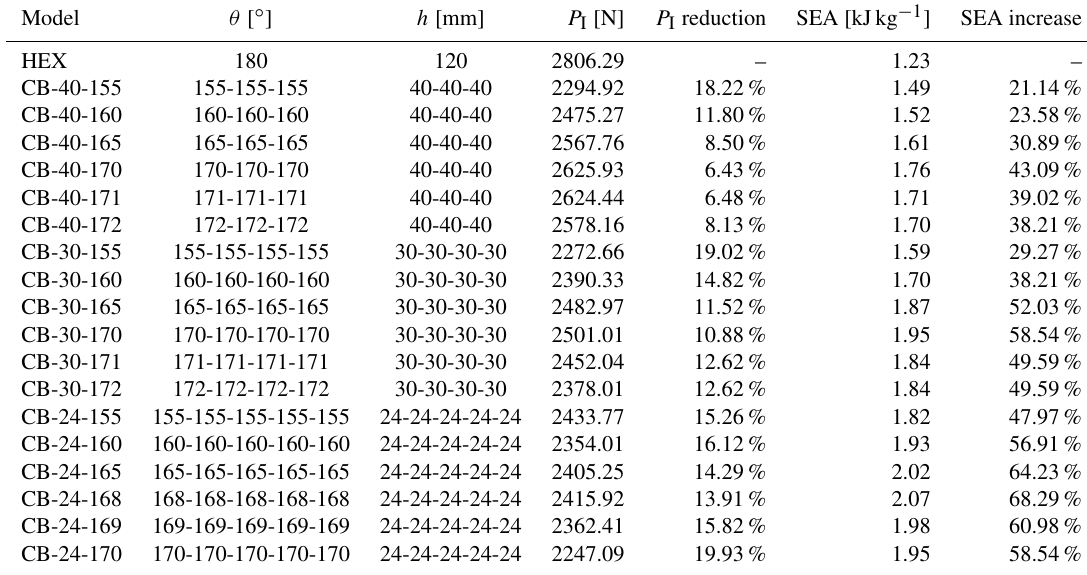
Table 1. Geometrical parameters and numerical results of uniform origami crash boxes.